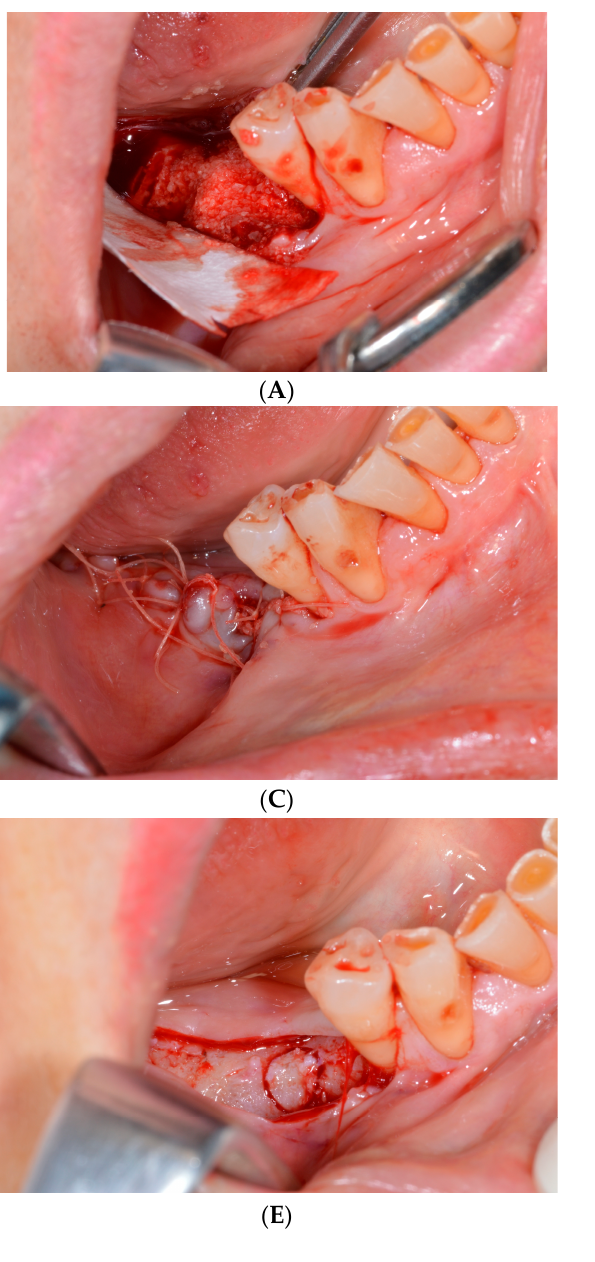
Figure 2. ( A ) Autologous tooth-derived graft material placed in alveolar post-extractive socket. ( B ) Tooth graft materials covered with a resorbable collagen membrane. ( C ) Suture. ( D , E ) Surgical bone biopsy excision after 4-month healing period before implant placement. ( F ) Group B bone histological specimens.